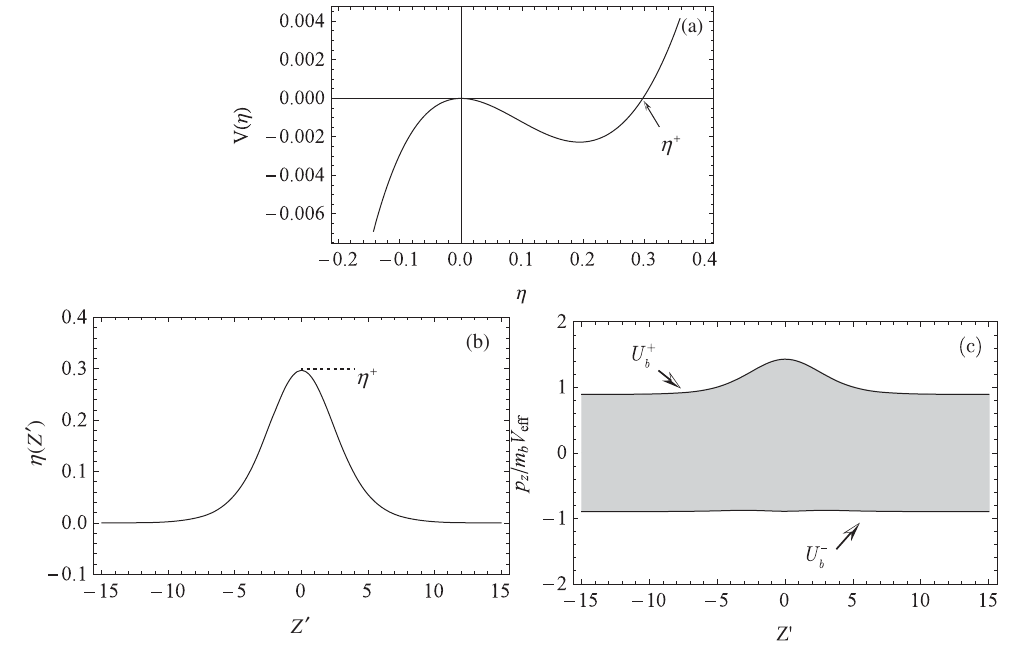
4 = 15 and E ¼ 0 , T ¼